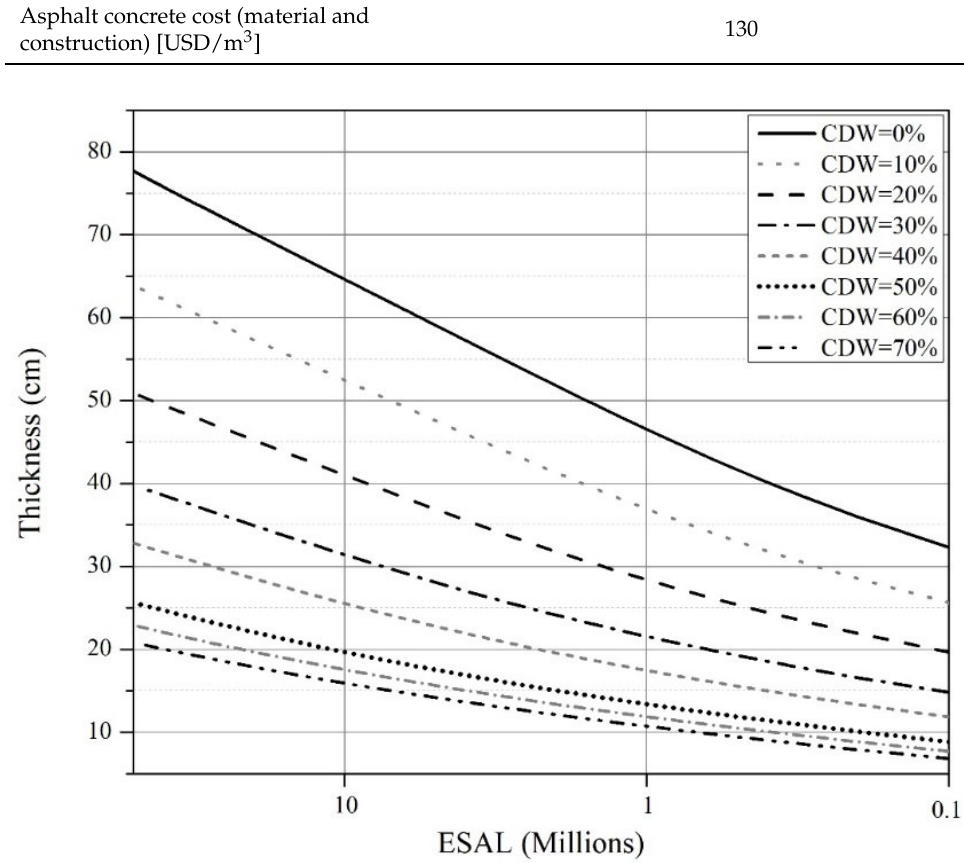
Figure 13. Total structural pavement thickness.